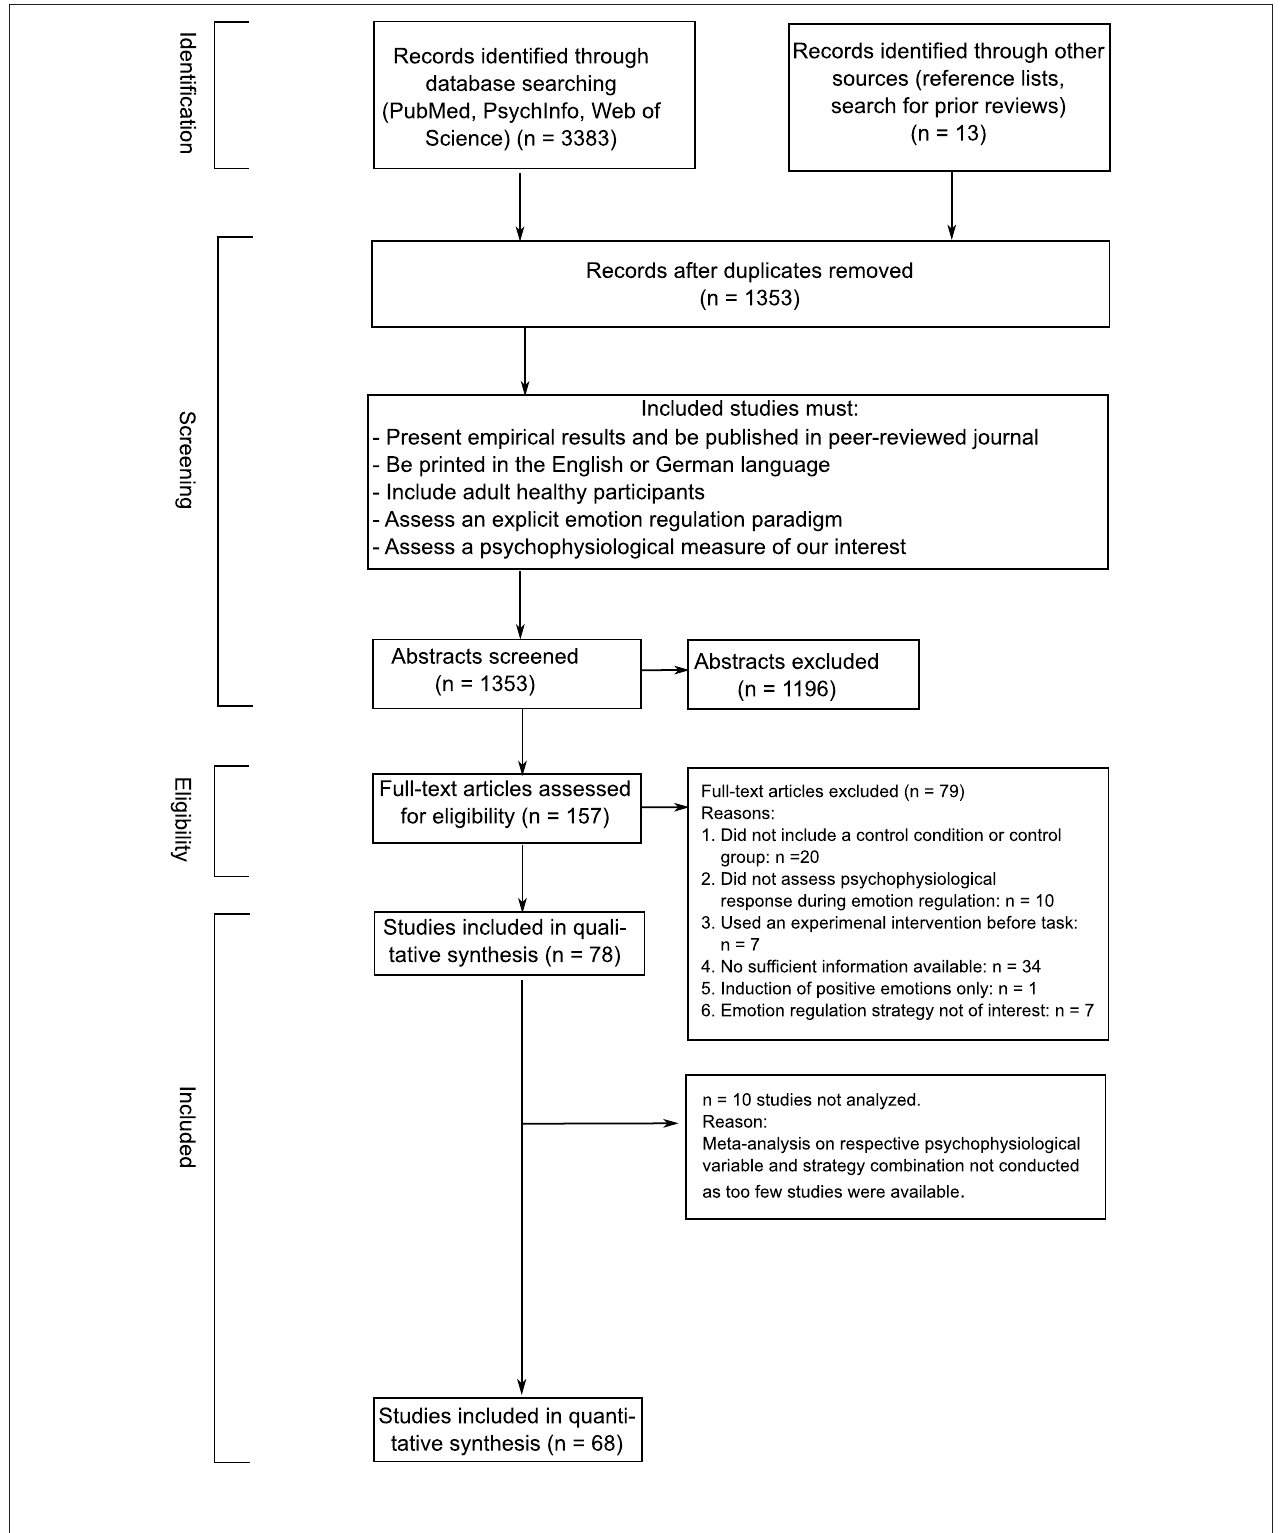
FIGURE 1 | PRISMA flowchart of the literature search process.